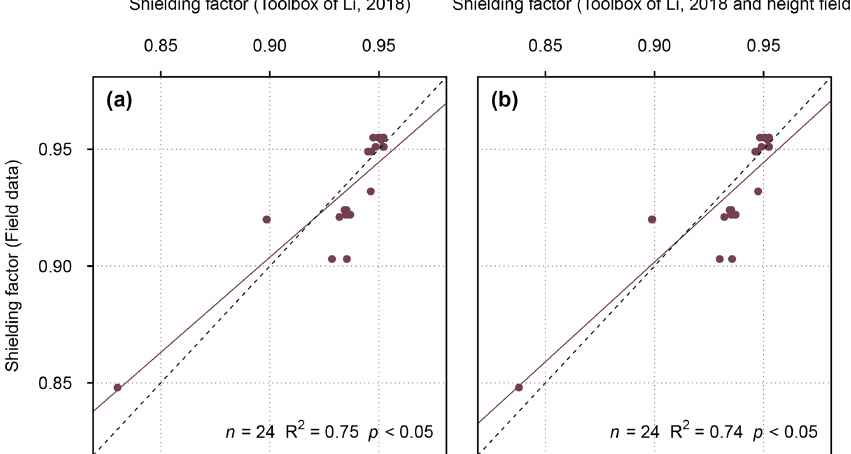
Figure 5. (a) Topographic shielding factors for boulders on moraines in the Écrins massif (Le Roy et al., 2017) derived from field data versus those determined with SRTM elevation data (NASA Jet Propulsion Laboratory, 2013). Panel (b) is the same as (a) , but the shielding factors determined with the toolbox are corrected for the boulder height.